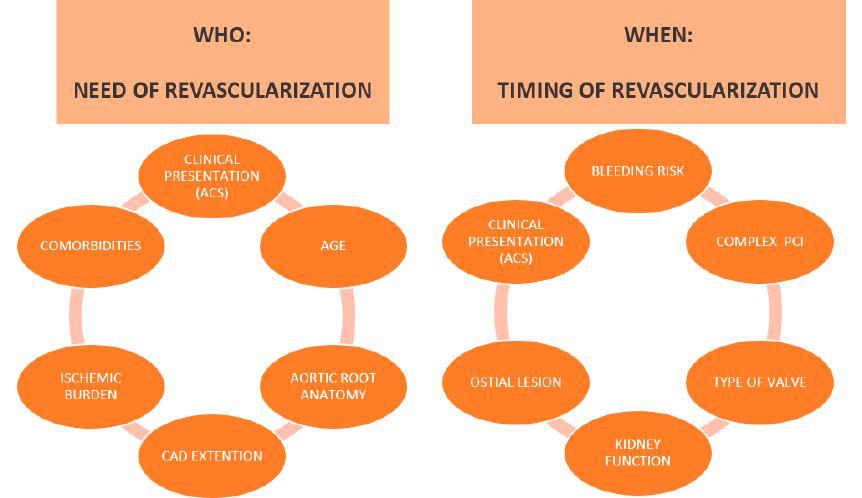
Figure 1. The management of CAD in TAVI patients: who need myocardial revascularization and when? Abbreviations: ACS, Acute coronary syndrome; PCI, Percutaneous coronary intervention; CAD, Coronary artery